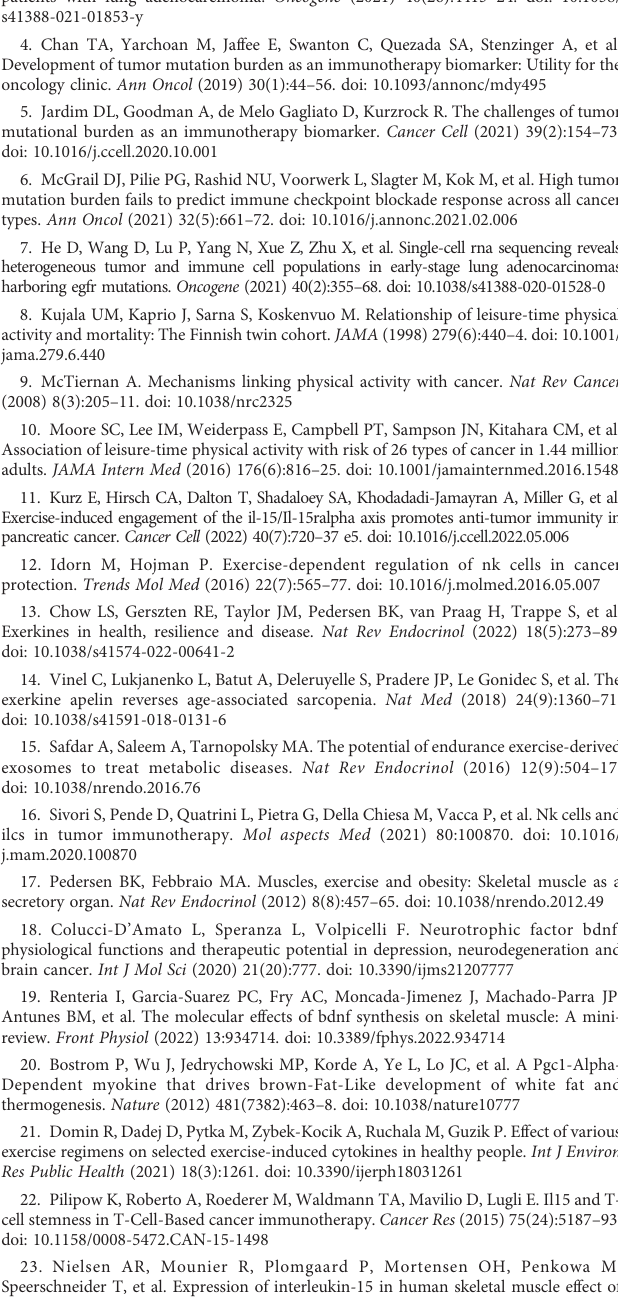
SUPPLEMENTARY FIGURE 3 Validation of subtype immune in fi ltration. (A) Differences in IPS between the two subtypes in the GEO cohort. (B) Using TIDE algorithm in the GEO cohort to predict the response rate to immunotherapy for high and low MFI groups.